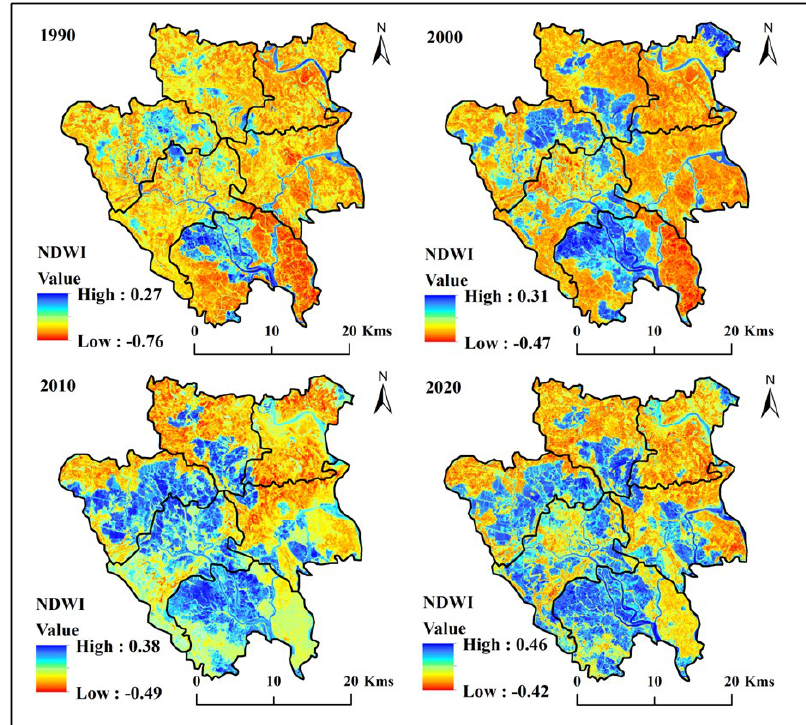
Figure 9. Normalized Difference Water Index (NDWI) maps of the study area.